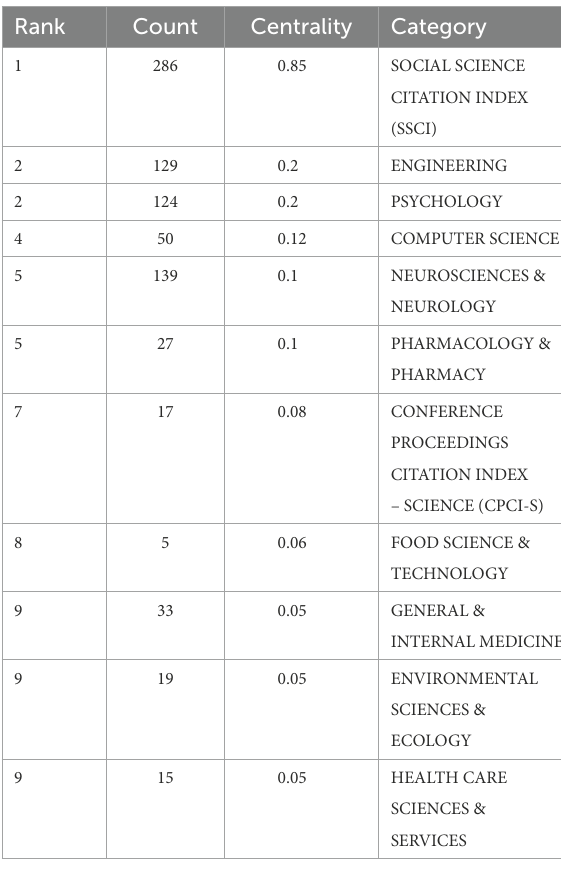
TABLE 2 Top 10 countries/regions by number of publications regarding effects of mental fatigue on athletic performance. Rank